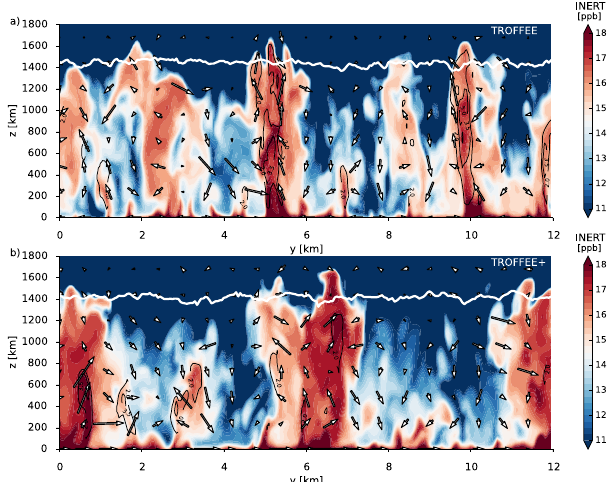
Figure 7. Parameterization for φ cc − φ(z b ) as a function of φ(z b ) − (cid:104) φ (cid:105) proposed by Ouwersloot et al. (2013). Here, φ represents the 24 transported species (note that only INERT, BLS, isoprene and CO are shown). Circles represent free convection situations, crosses indicate wind situations. The solid line represents a least square fit through all data, which is forced through 0. d represents the index of agreement. The inset shows solely the INERT species for wind and no wind experiments.